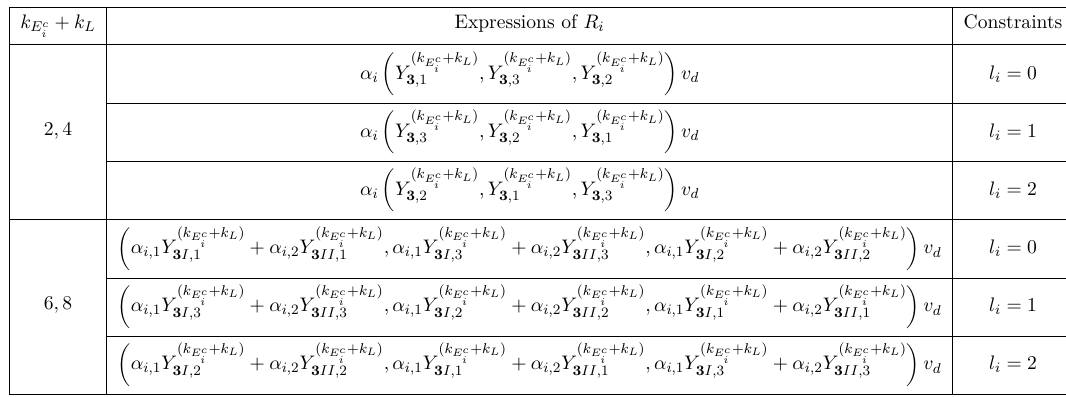
Table 2 . Possible structures of each row R i of the charged lepton mass matrix for modular forms up to weight 8, where α